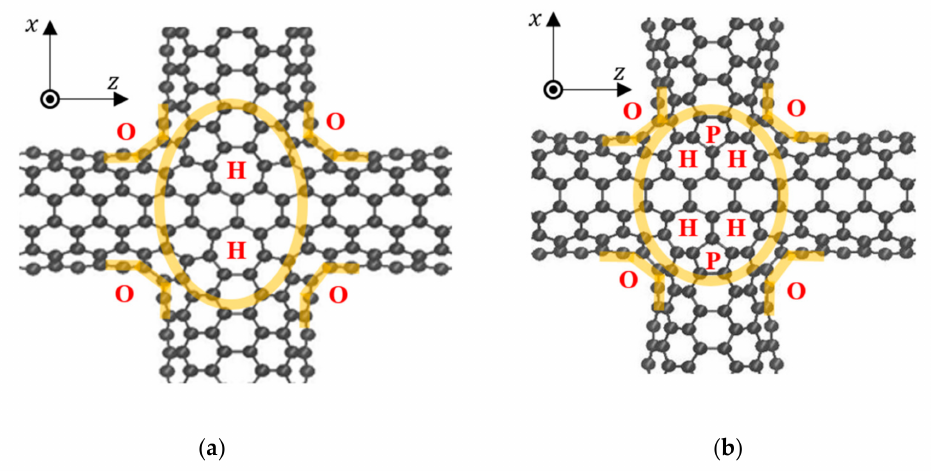
Figure 3. Atomic configurations of two cross-junctions: ( a ) cross-junction 1 and ( b ) cross-junction 2 (P, H, and O represent pentagons, heptagons, and octagons, respectively). Equal-length (6, 6) CNTs were connected to T-junctions and cross-junctions to